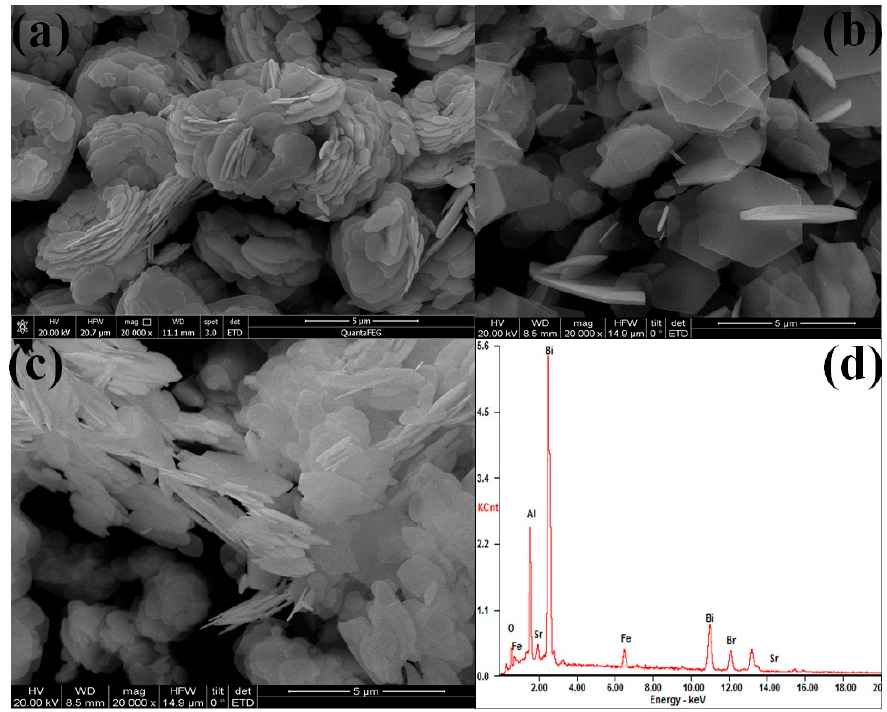
Figure 2. Scanning electron microscope (SEM) images of pure( a ) BOB, ( b ) SFO, and ( c ) BOB/SFO-5; ( d ) energy dispersive analysis (EDS) of BOB/SFO-5.